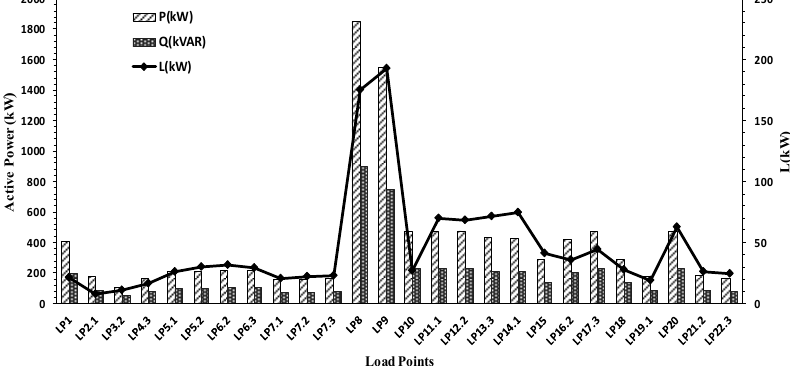
Figure 5. Test system configuration of the IEEE RBTS distribution section.